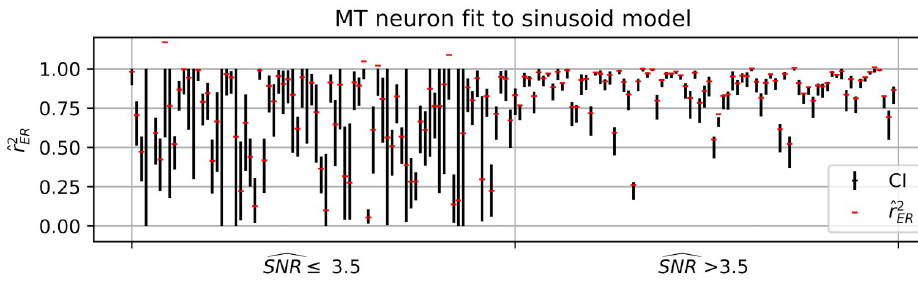
Fig 8. Confidence intervals ( α = 90%, vertical lines) and point estimates (red dashes) for ^ r 2 direction tuning curves fit to sinusoidal model. Data points are grouped into two intervals on the basis of d SNR (of the direction tuning curves) being less than or equal to or higher than the median value (3.5), revealing that lower SNR (left interval) is associated with much longer CIs.